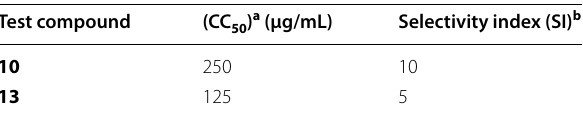
a CC 50 is the concentration of compound required to kill 50% of the fibroblast cells b The selectivity index (SI) was calculated using the formula, SI